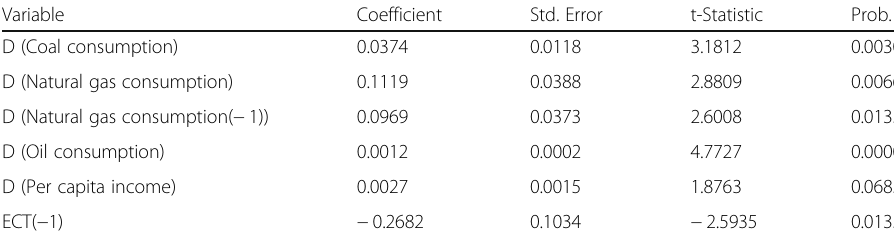
Table 6 Short Run ARDL